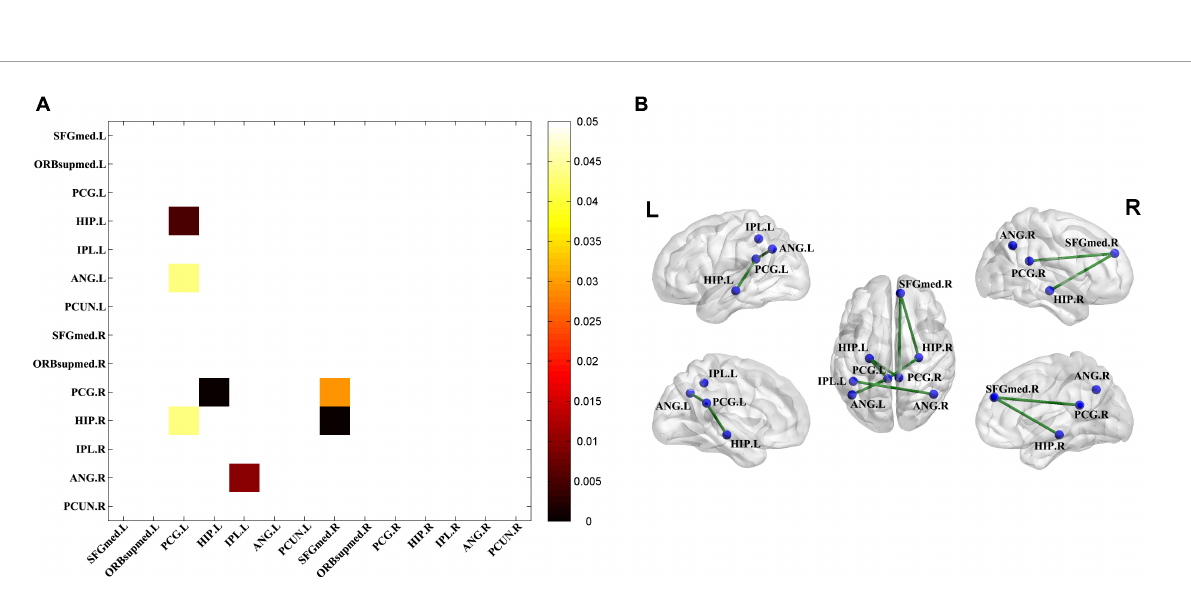
FIGURE3 Significantly decreased metabolic connectivity in the TLE groups. (A) The seven significantly decreased metabolic connections in the TLE groups compared with the HC group (permutation test, P < 0.05 with FDR correction). Statistical significance of the reduction of metabolic connectivity in the TLE group was found and represented by lower triangular matrix. (B) The anatomical distribution of significantly different metabolic connections in pairwise VOIs between the TLE and HC